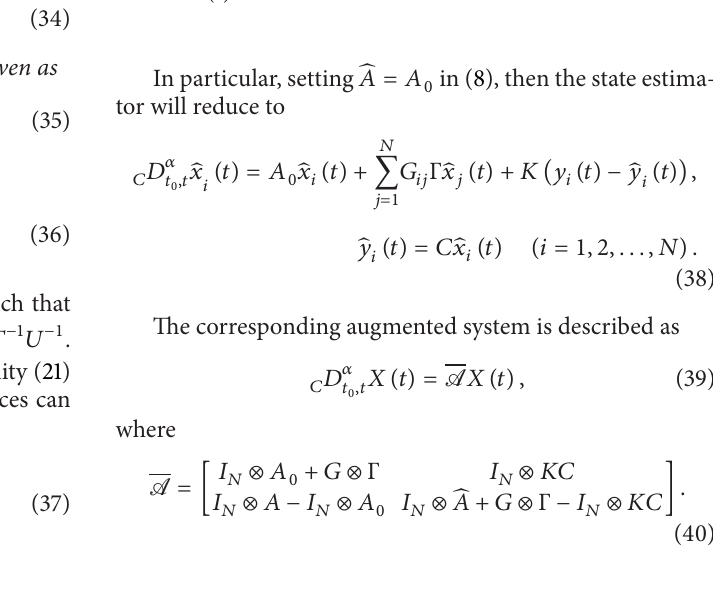
Figure 2: The curve of error 𝑒(𝑡) between the state 𝑥(𝑡) and its estimate ̂𝑥(𝑡)